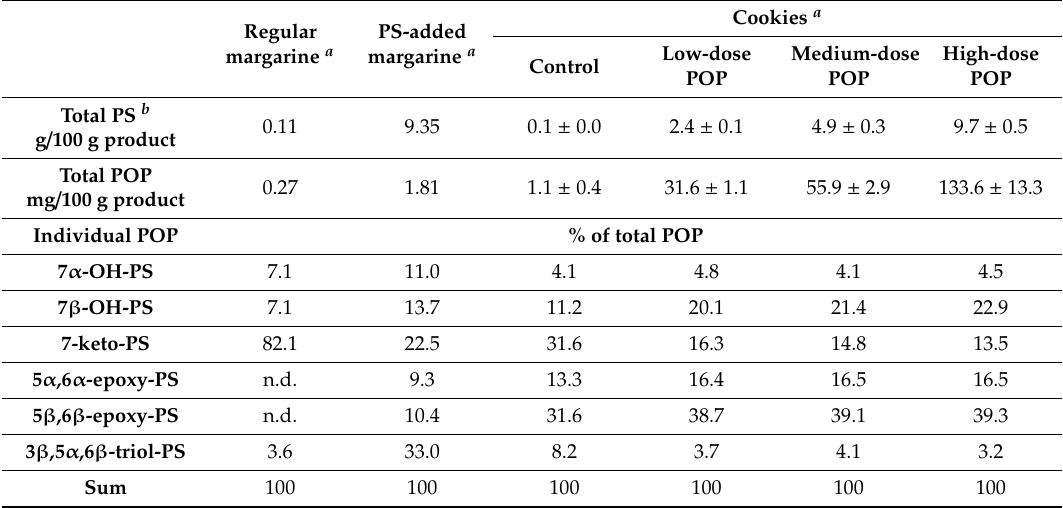
5 α ,6 α -epoxy-PS 5 β ,6 β -epoxy-PS